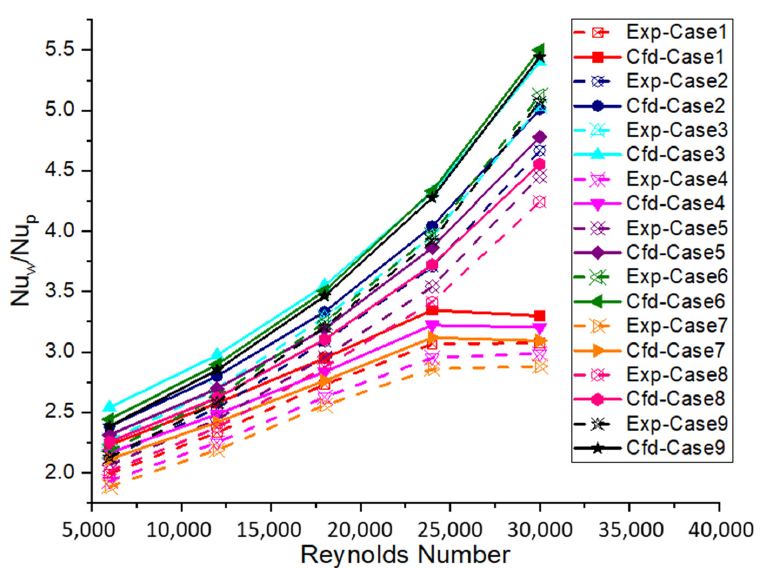
Figure 11. Augmented values of Nusselt Number Ratio over Reynolds Number.